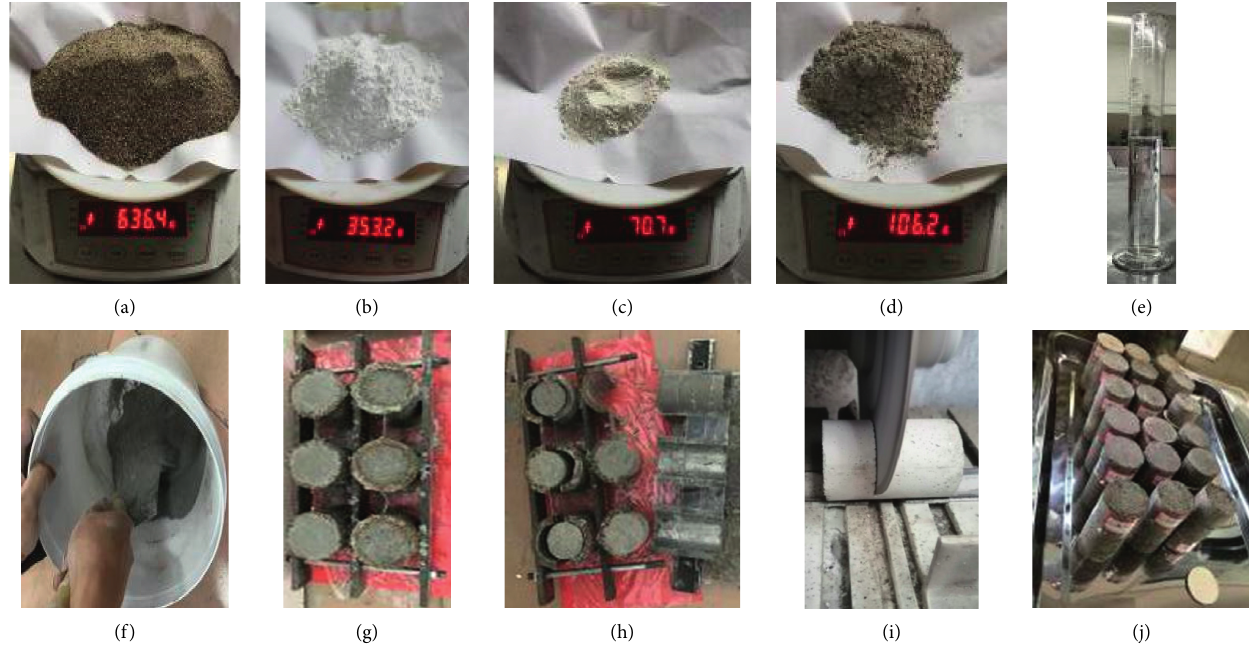
Figure 7: Preparation of samples: (a) river sand; (b) barite powder; (c) gypsum; (d) cement; (e) water; (f) stirring; (g) compacting; (h) demolding; (i) cutting; (j) partial samples.